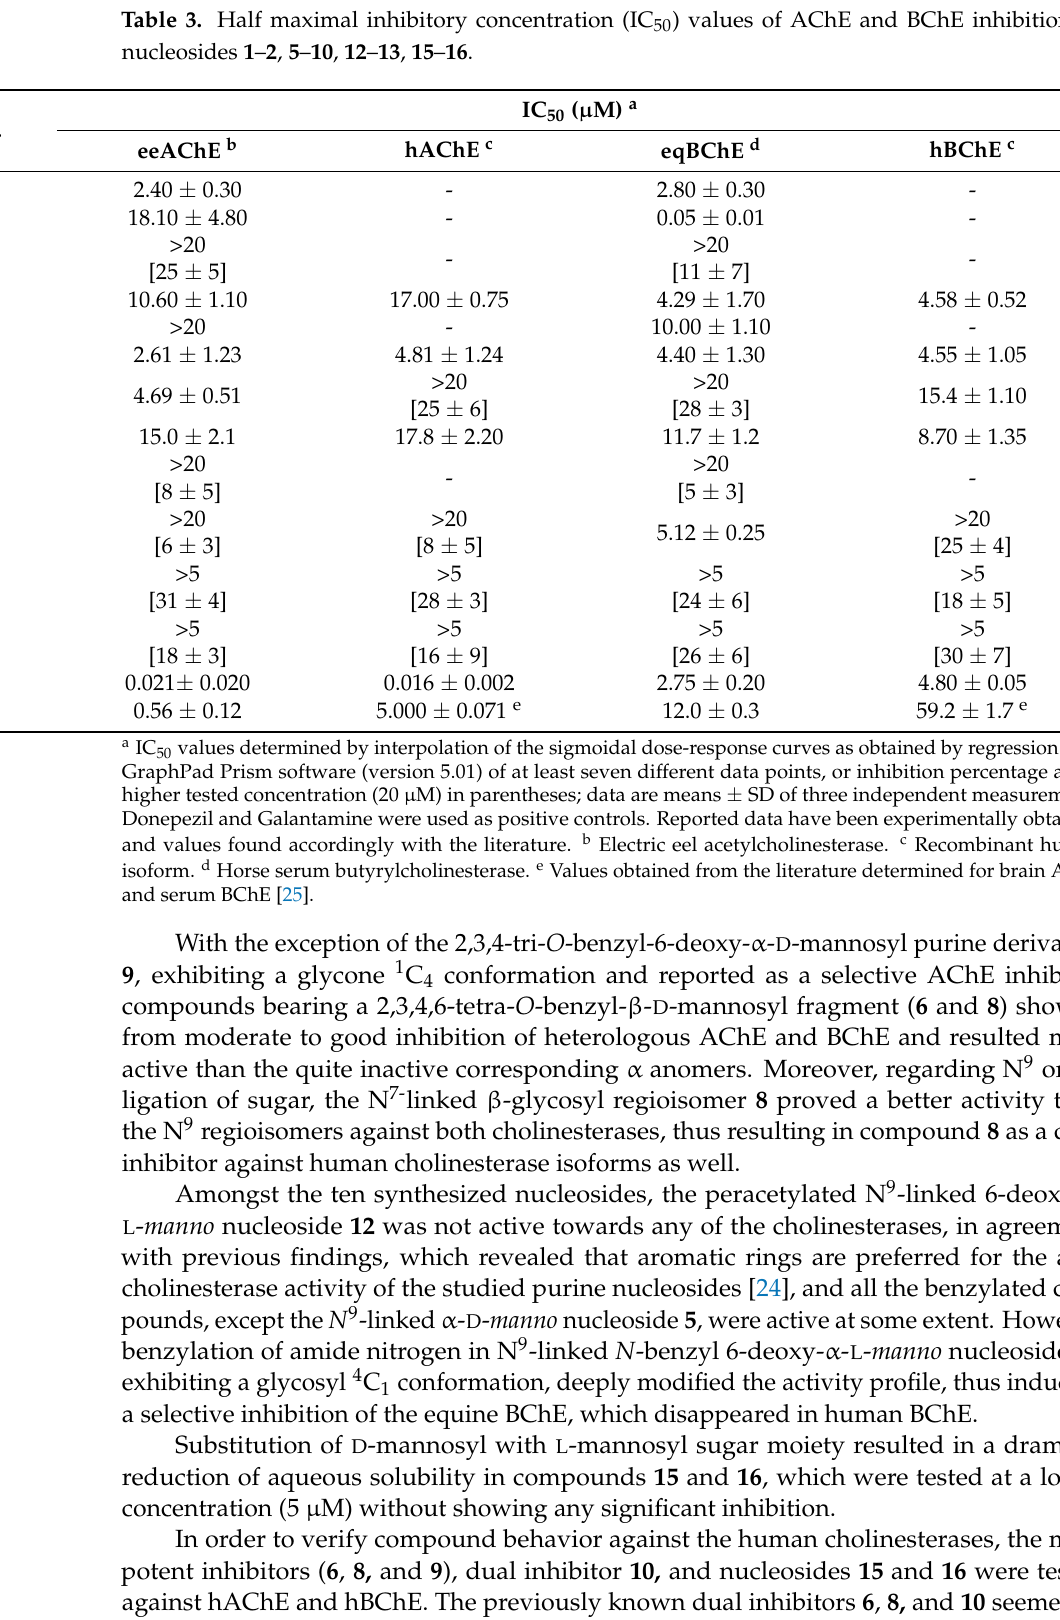
Table 3. Half maximal inhibitory concentration (IC 50 ) values of AChE and BChE inhibition by